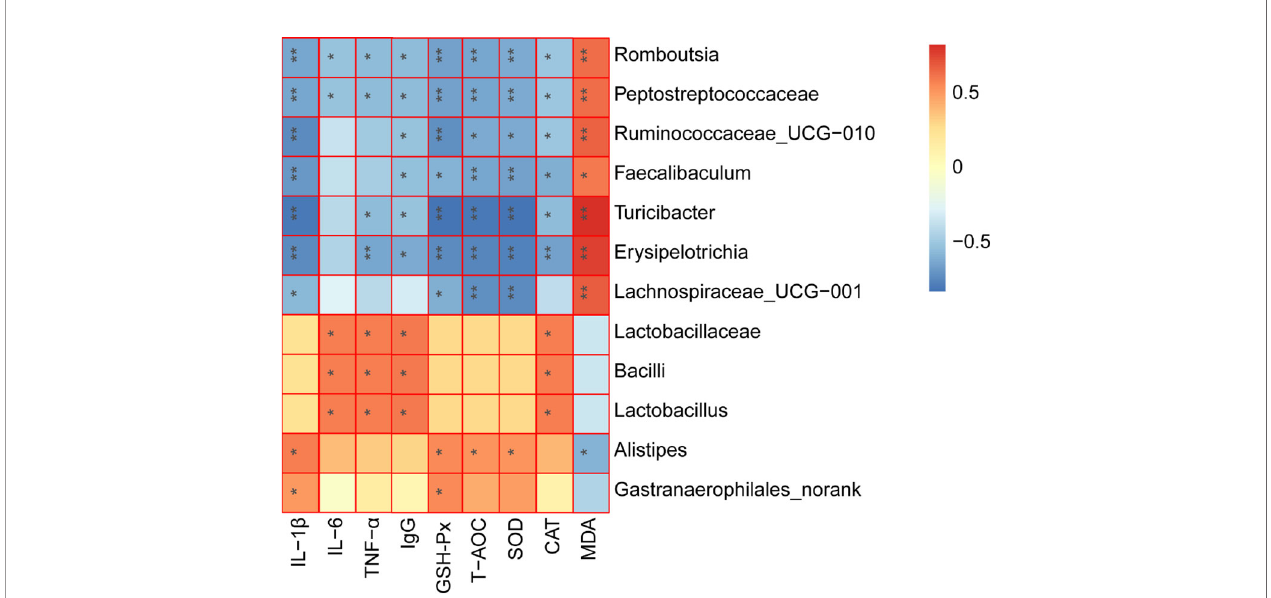
FIGURE 8 | Spearman correlation analysis between the key microbial communities and immune-related biochemistry parameters. * P < 0.05, ** P <